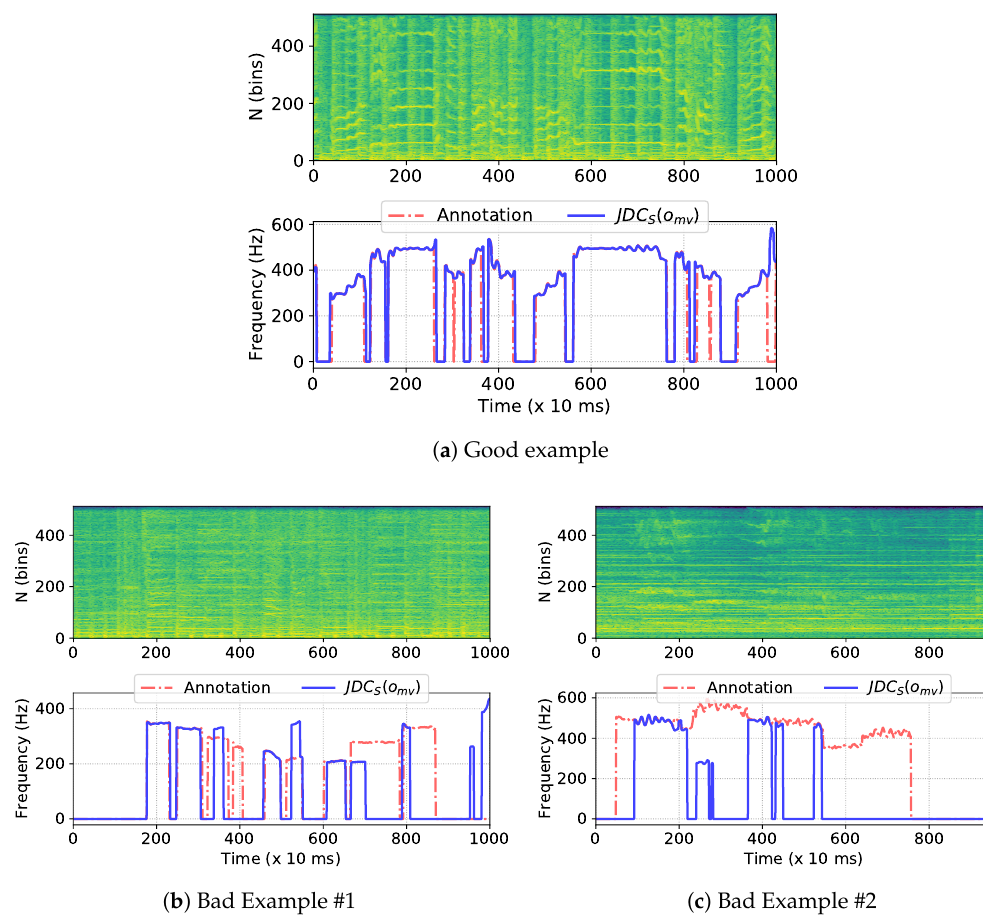
Case examples of singing melody extraction from the MedleyDB dataset: ( a ) good example (“MusicDelta-Gospel”) and ( b , c ) bad examples (“CelestialShore-DieForUs”,